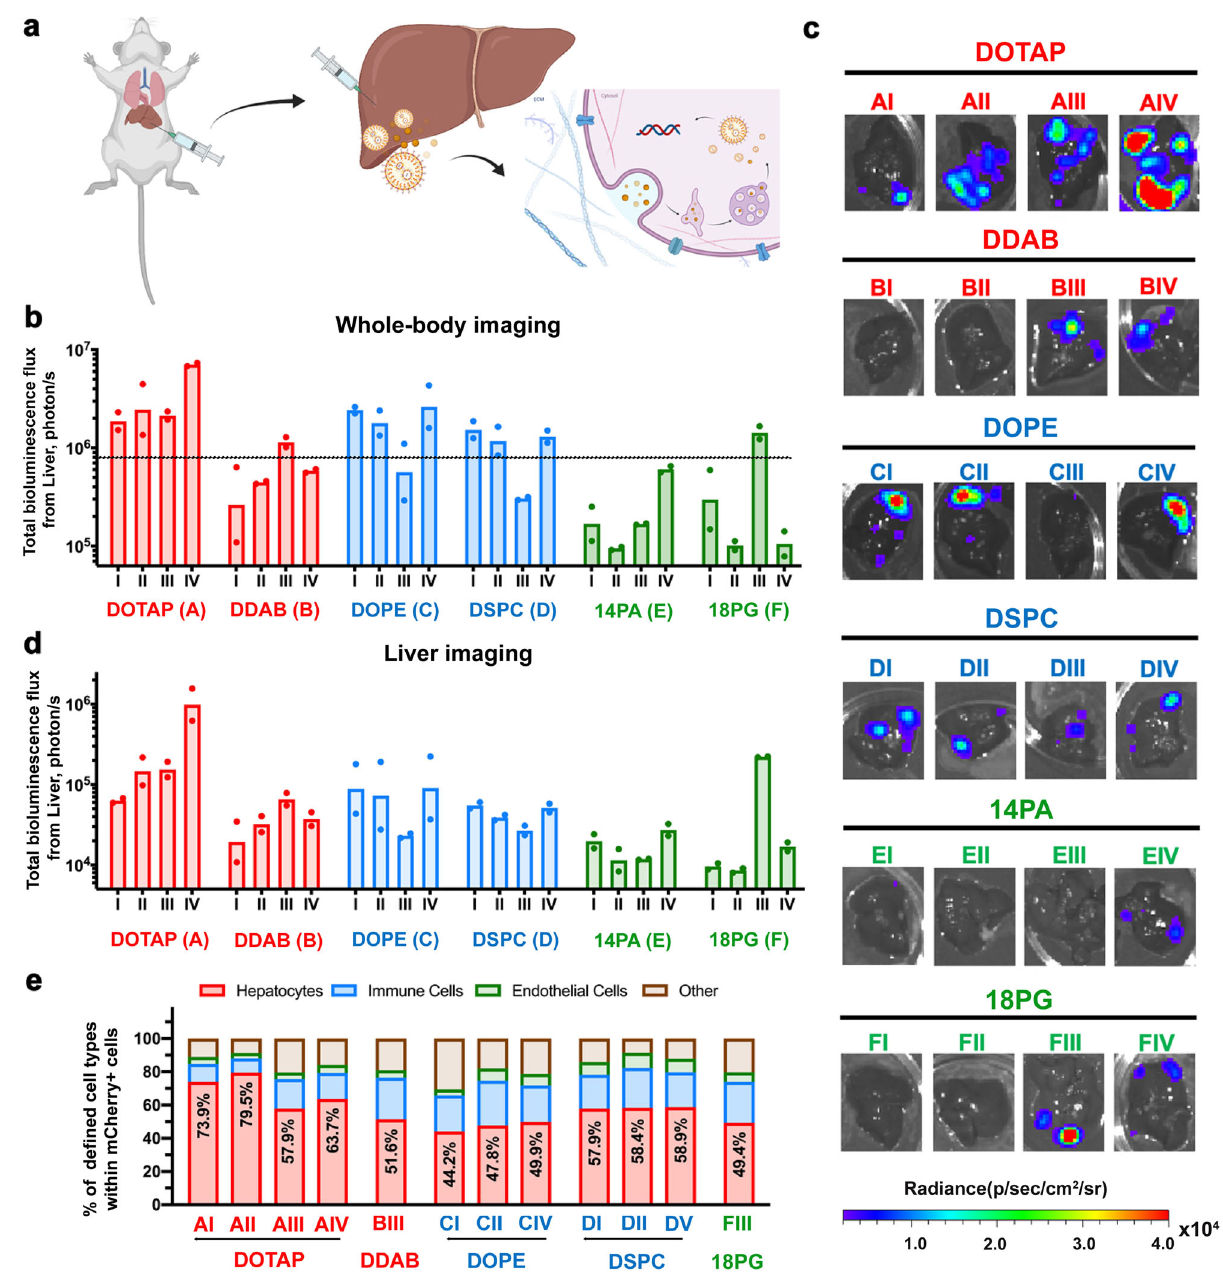
Fig. 3 | LNP-mediated local intrahepatic pDNA delivery in cluster-mode screening.a Schemeforintrahepaticdelivery. b Whole-bodybioluminescence fl ux of female BALB/c mice (6 – 8 weeks) at 12h following a single intrahepatic injection of different LNP formulations containing 3 μ g of pDNA (50% Luc+ 50% mCherry) per mouse ( n =2, 48 for the whole experiment). Ex vivo c imaging